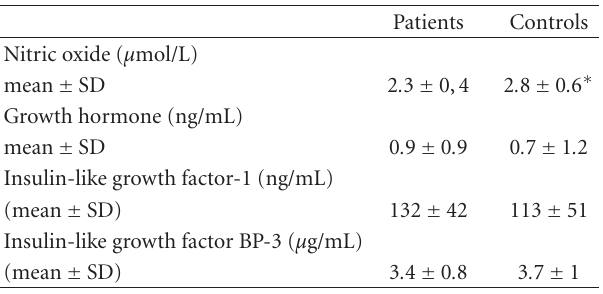
Table 2: Nitric oxide, growth hormone, insulin-like growth factor- 1, and insulin-like growth factor BP-3 levels of the patients with PD and healthy